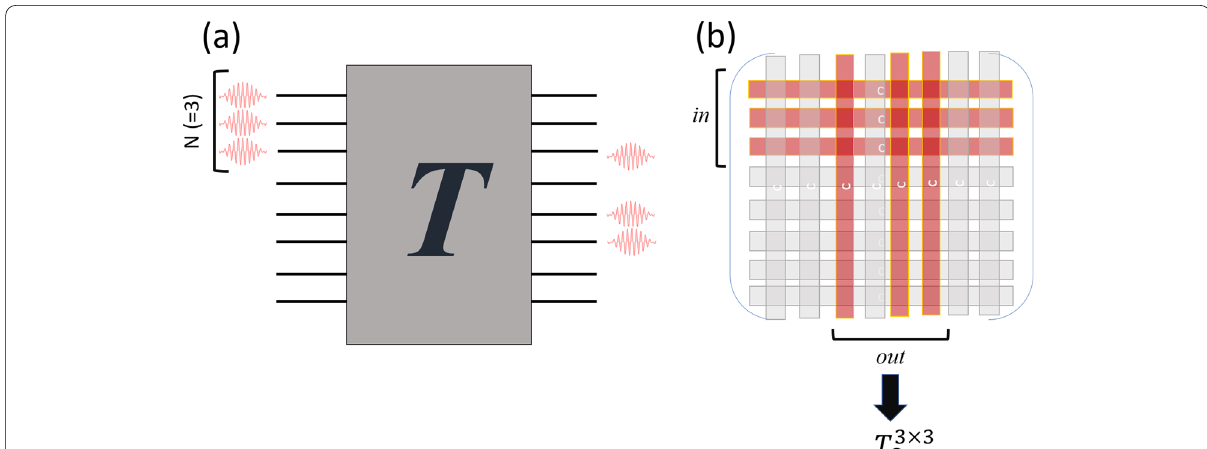
Fig. 4 Figure adapted from [114]. An illustration of the Boson Sampling procedure. a N photons are injected into an interferometer T that simulates an unitary matrix. b By obtaining the probabilities of observing the output distribution of the photons n , the permanent of a submatrix in T can be subsequently calculated, Pr( n ) |Perm( T s )| =